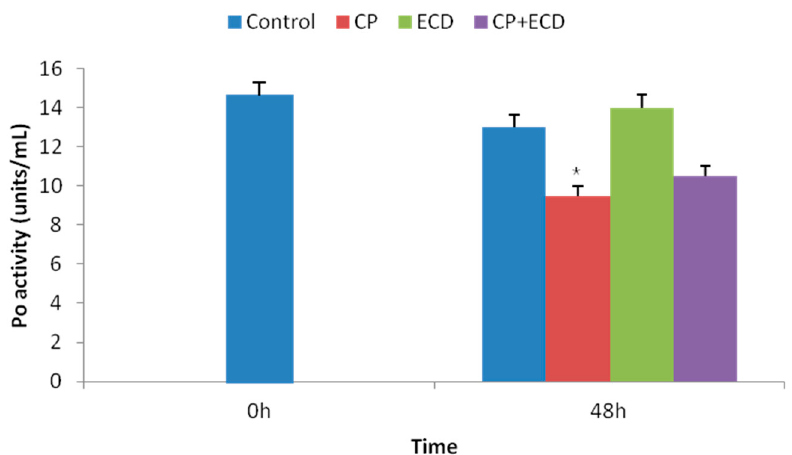
Figure 6. Effect of acute water-salinity stress for 48 h on phenoloxidase activity in abalone ( H. discus ) after feeding on the experimental diets supplemented with CP (6%), ECD (6%), and CP + ECD (3% + 3%) for 12 weeks. Vertical bars represent the SE of the means of three experiments. * p < 0.05 for control level at 48 h.